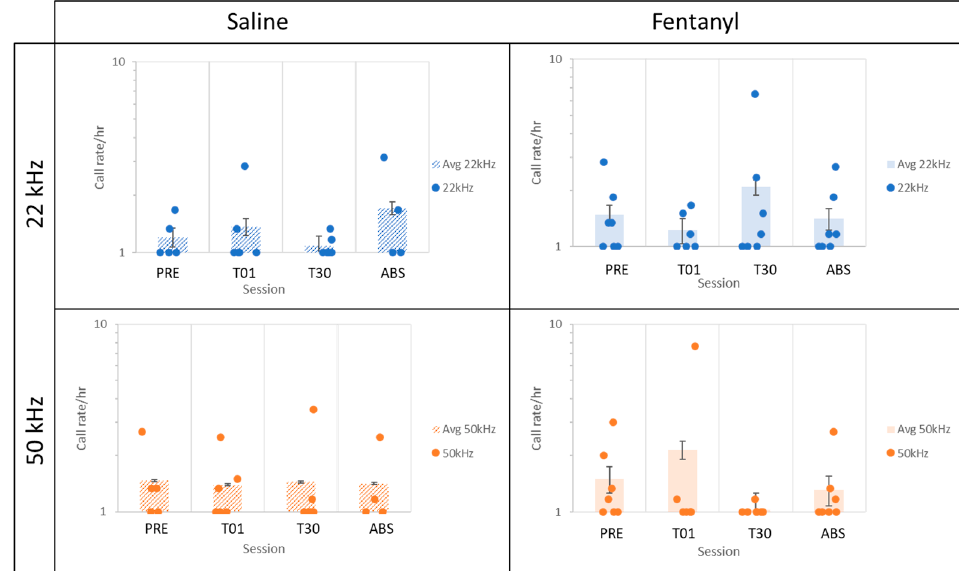
Figure 3. The 22 kHz and 50 kHz call rates per hour. Each bar represents the mean call rate per hour at PRE, T01, T30, and ABS for both saline and fentanyl groups. Each dot represents one animal. The fentanyl group exhibited a shift toward negative affect after 30 days of fentanyl SA as indicated by the increase in 22 kHz calls and decrease in 50 kHz calls at T30 compared to T01. This change was not observed in the saline group. Two data points (one fentanyl T30 and one saline PRE) were outliers and removed from Figure 3 , but not from statistical analyses, so that the visualization of the data is consistent with the results showing a shift toward negative affect at T30. Note the non-linear scale on the y-axis. Error bars denote the SEM.